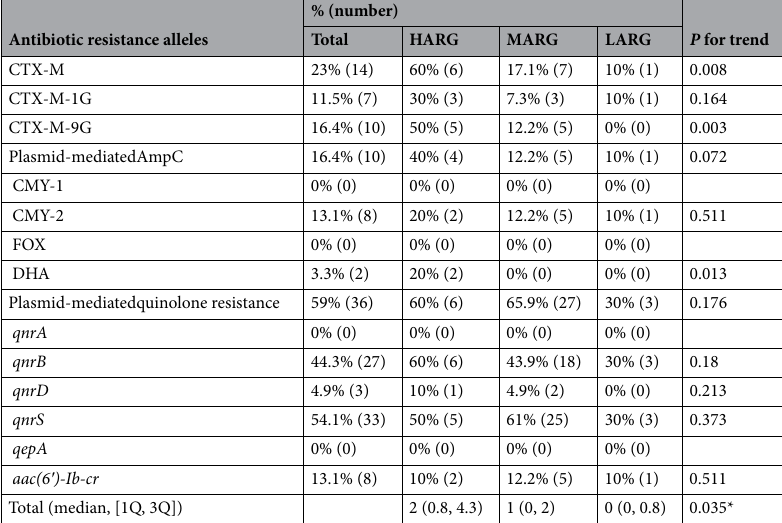
Table 2. Faecal carriage rate of CTXM, plasmid-mediated AmpC, and plasmid-mediated quinolone resistance alleles in 61 healthy people. Plasmid-mediated carbapenemase alleles were not identified. HARG high antibiotic resistance genes group, MARG middle antibiotic resistance genes group, LARG low antibiotic resistance genes group. CTX-M-1G, CTX-M-1 group; CTX-M-9G, CTX-M-9 group. *By Kruskal ‒ Wallis test.